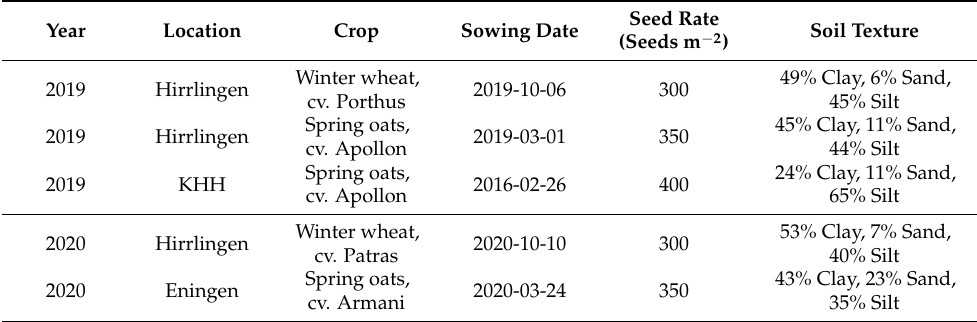
Table 1. Year, location, crop with cultivar, sowing date (YYYY-MM-DD), seed rate, and soil texture of all five experiments in 2019 and 2020.